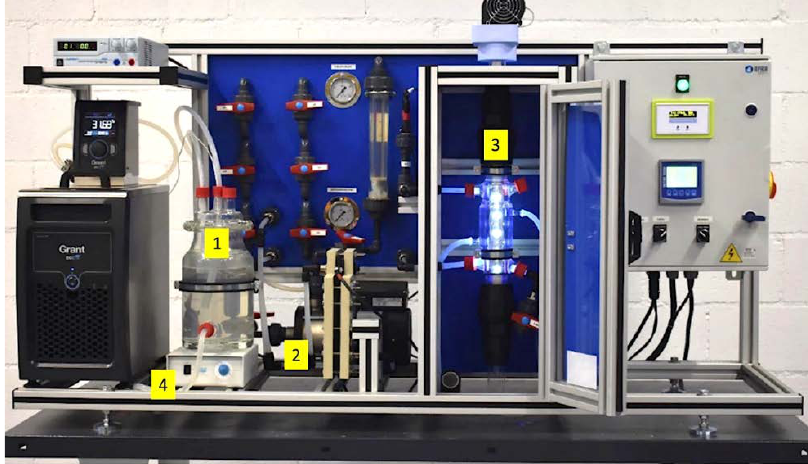
Figure 7. Experimental set-up, APRIA Systems; (1) mixing tank, (2) pump, (3) LED reactor and (4) magnetic stirrer.